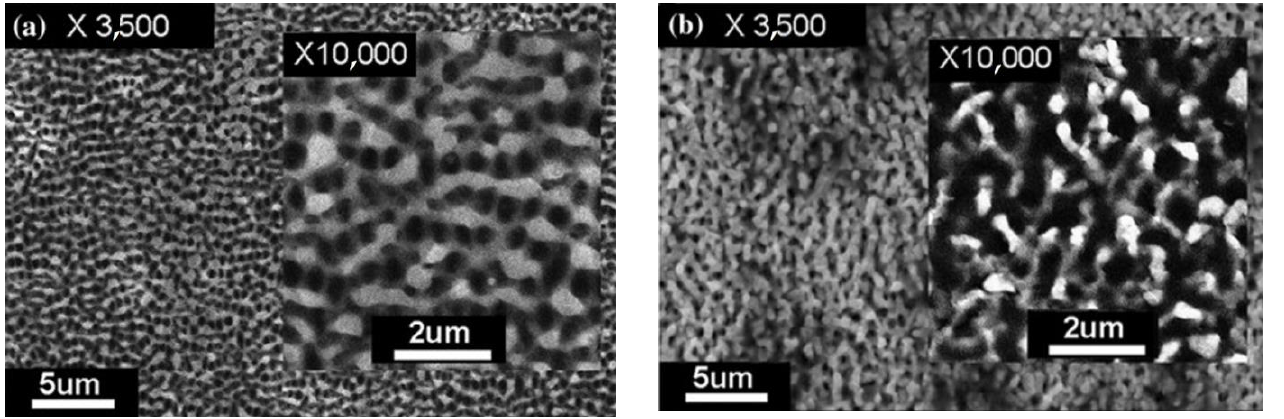
Figure 11. Porous structures in ethanol environment. ( a ) Quasiordered array of holes when the scan speed was 320 μ m/s; ( b ) unordered netlike structure when the scan speed was 20 μ m/s. “Reprinted with permission from Ref. [44], Copyright (2013), Elsevier”.